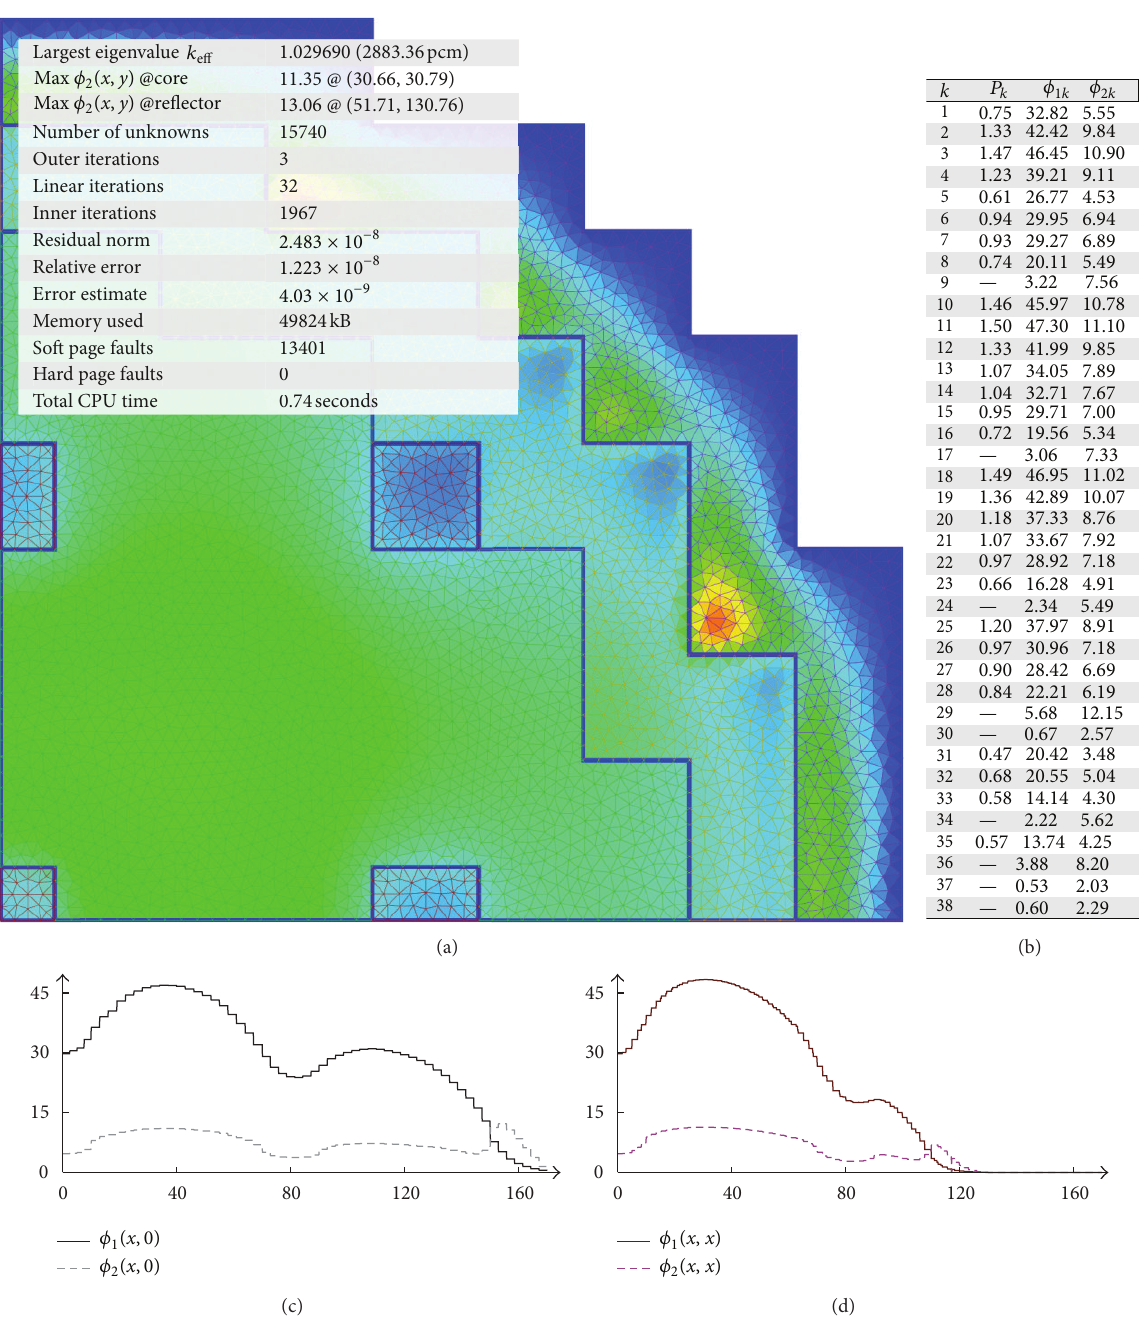
Figure 10: (a) Mesh and thermal flux distribution. (b) Power and fluxes. (c) Flux distribution 𝜙 𝑔 (𝑥,0) along the 𝑥 -axis. (d) Flux distribution (𝑥,𝑥) along the 𝜙 𝑔